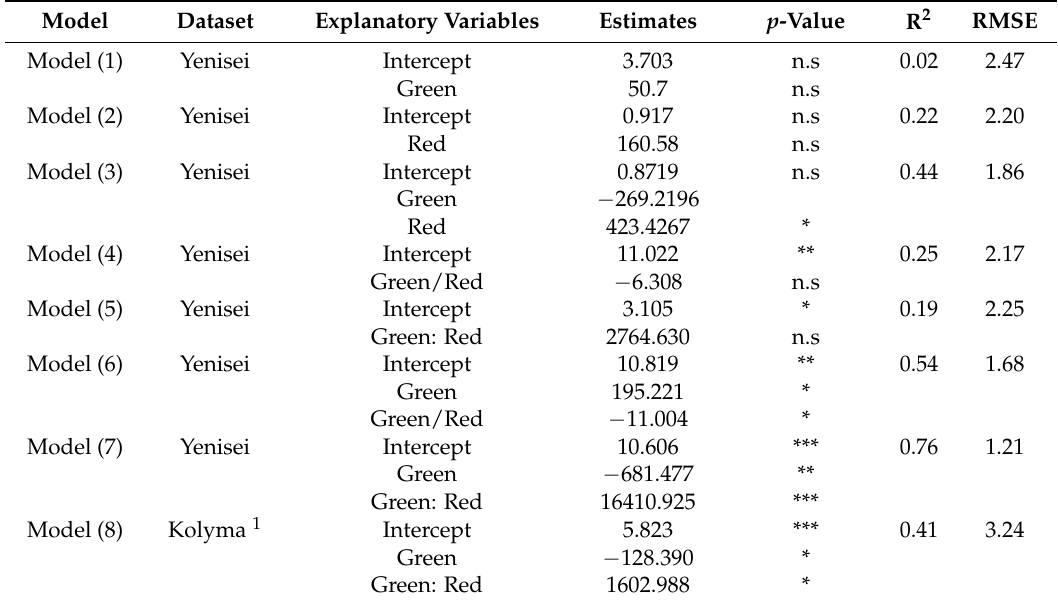
Table 4. Results of linear regression explaining CDOM at 440 nm (m − 1 ). Slashes are used to express spectral bands ratio, whereas semicolons are used to express spectral bands